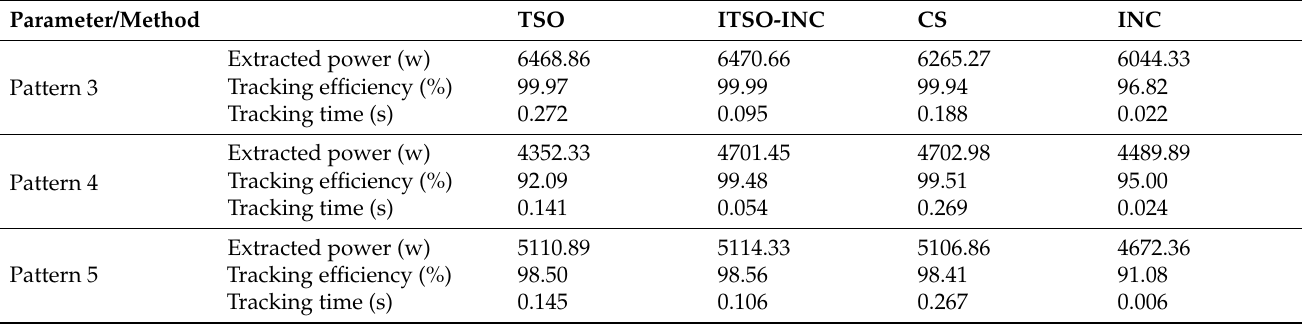
Table 9. Numerical results of TSO, ITSO-INC, CS, and INC methods in pattern 3 and pattern